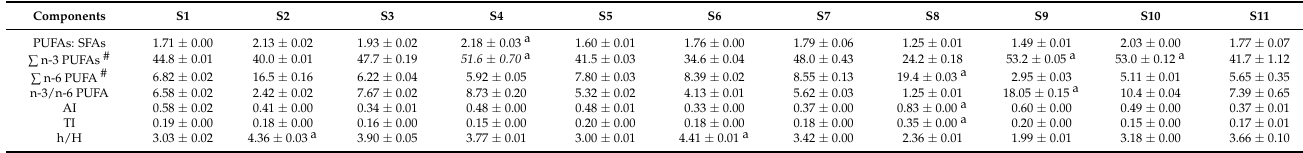
Table 5. Fat quality indices of lipids obtained from shellfish species.